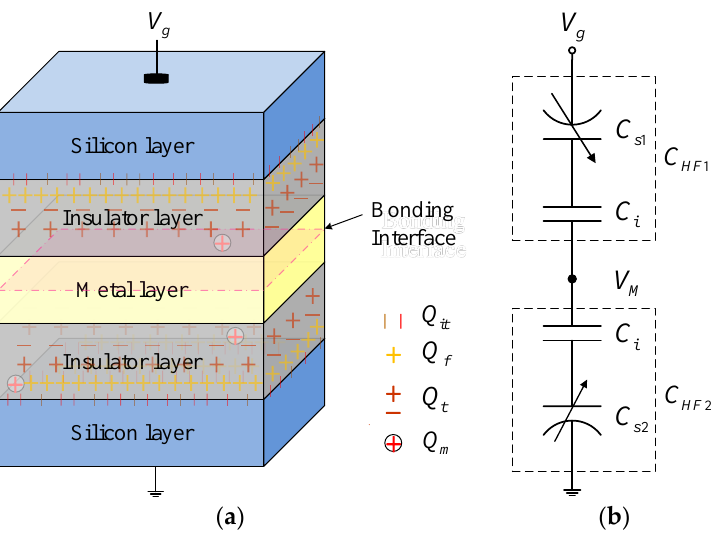
Figure 1. ( a ) Three-dimensional view and ( b ) high-frequency equivalent circuit model of the stacked bonding structure in 3D integration.